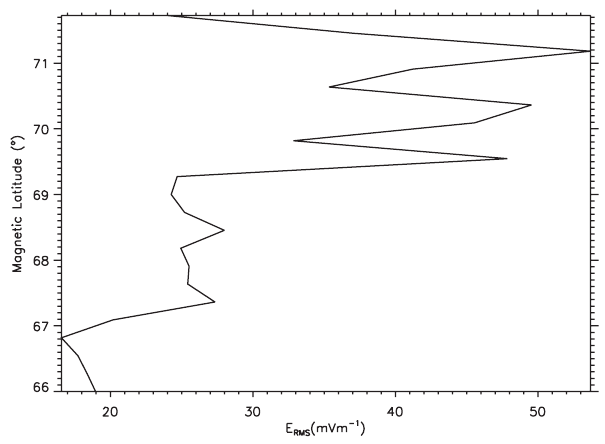
Fig. 5. The root mean squared electric field magnitude observed in Prince George beam 5 during the interval 02:00–03:00 UT as a function of magnetic latitude.